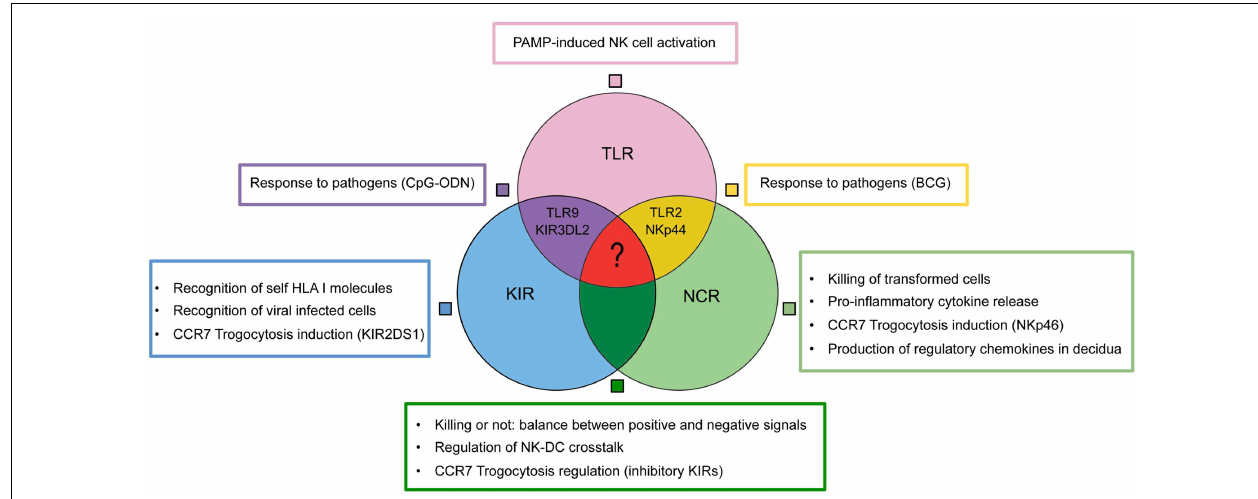
FIGURE 2 | Collaboration model betweenTLRs, KIRs, NCRs for NK cell activation .